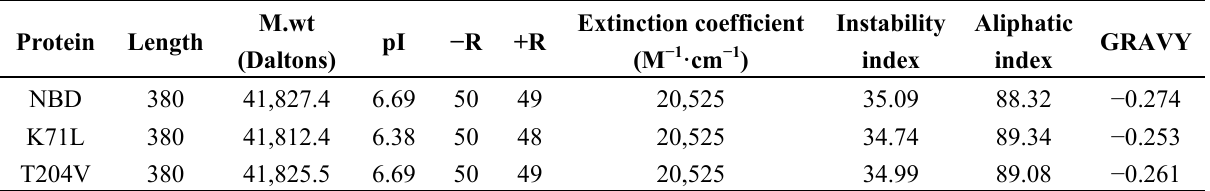
Table 1. The physiochemical character of the NBD protein, K71L and T204V mutants as predicted by Expasy’s Prot-Param program.